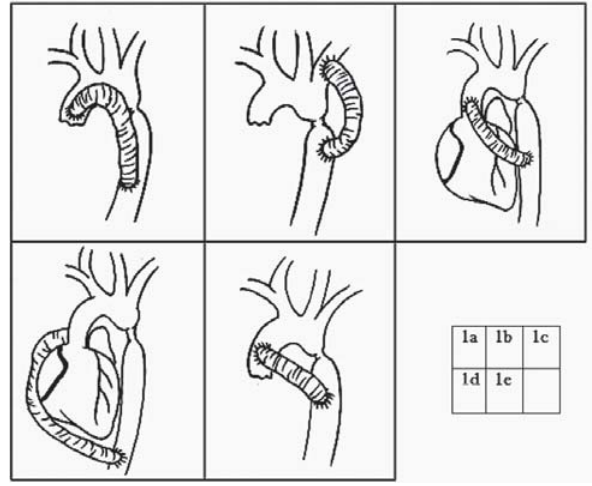
Fig. 1 - Desenho esquemático das várias abordagens para tratamento de coarctação de aorta através de desvios extra-